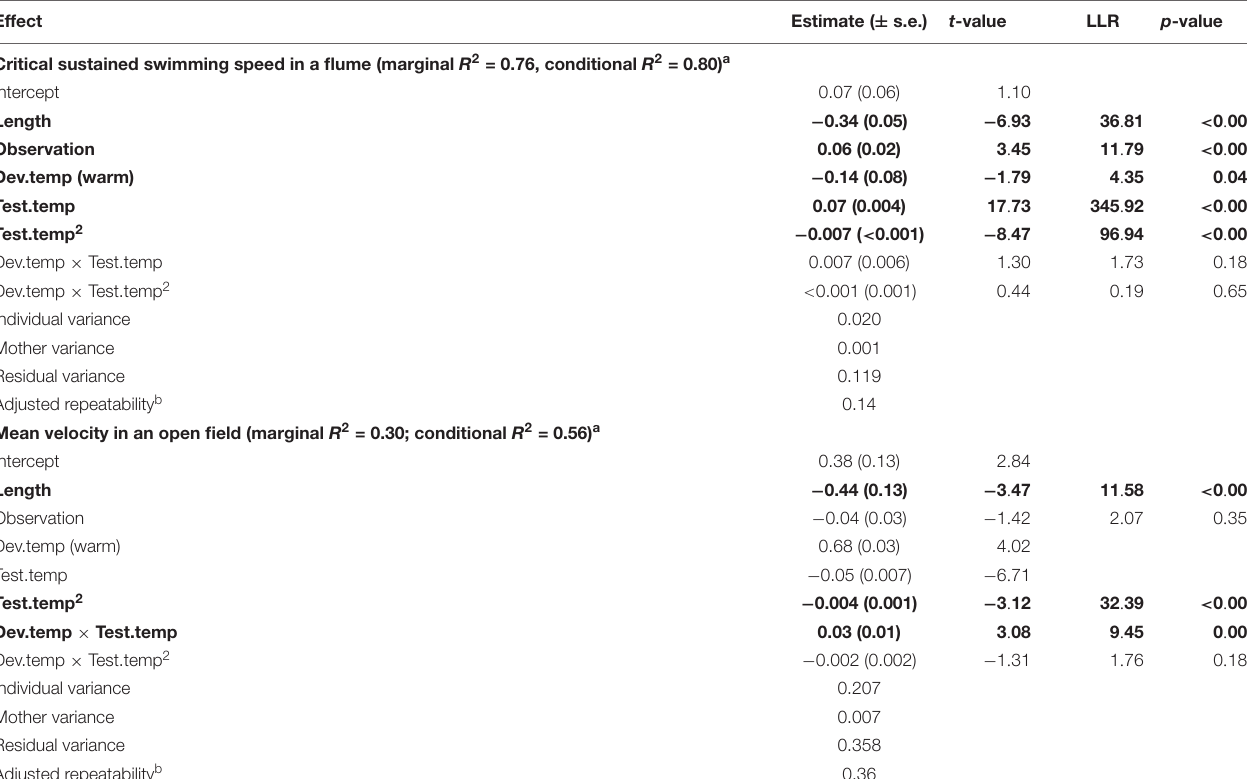
TABLE 2 | Linear mixed effect model predicting mean velocity and critical sustained swimming speed ( U crit ) in the Amazon mollies . Effect Estimate ( ± s.e.) t